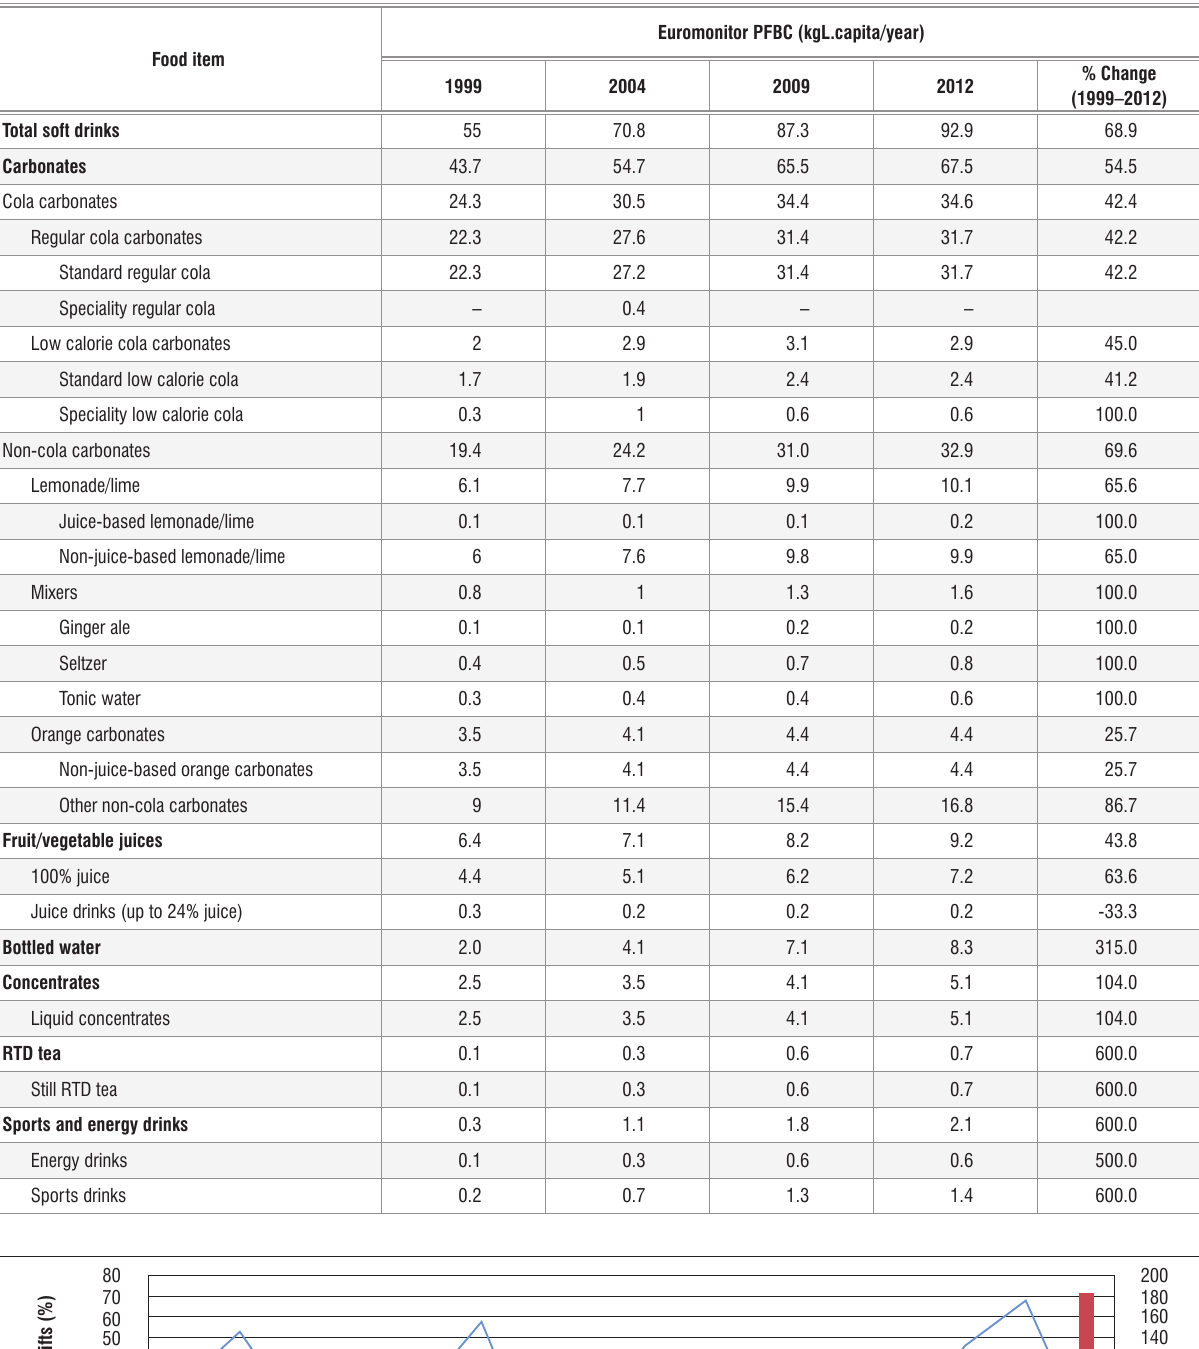
Table 9: Consumption of soft drinks in South Africa according to Euromonitor Packaged Food and Beverage Consumption (PFBC)